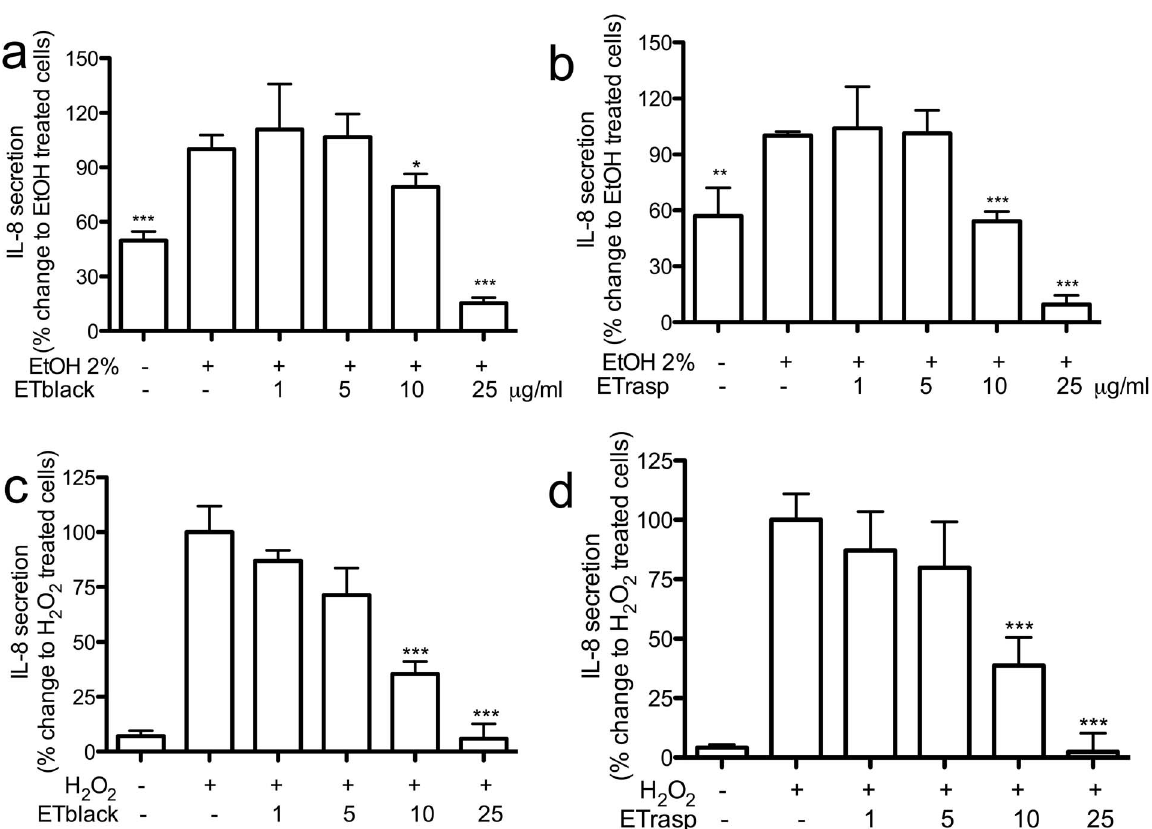
Figure 6. Effect of ETs from blackberry and raspberry on IL-8 release induced by EtOH and H 2 O 2 . Cells were grown in 24-well plates for 48 hrs (30000 cells/well) and then incubated for 12 hrs in the presence of 500 m M H 2 O 2 (panels a and b), or for 24 hrs in the presence of 2% ethanol (panels c and d). IL-8 was quantified by using Interleukin-8 High Sensitivity Human ELISA Set (Immunotools, Germany). The amount of IL-8 in the samples was detected by spectroscopy (signal read 450 nm, 0.1 s) by the use of biotinylated and streptavidin-HRP conjugate antibodies, evaluating 3,5,3,5 9 -tetramethylbenzidine (TMB) substrate reaction. 10 m M quercetin, used as reference inhibitor, completely inhibited EtOH and H 2 O 2 induced IL- 8 secretion. Results are the mean 6 sd of three experiments in triplicate. * p , 0.05, ** p , 0.01, ***p , 0.001.